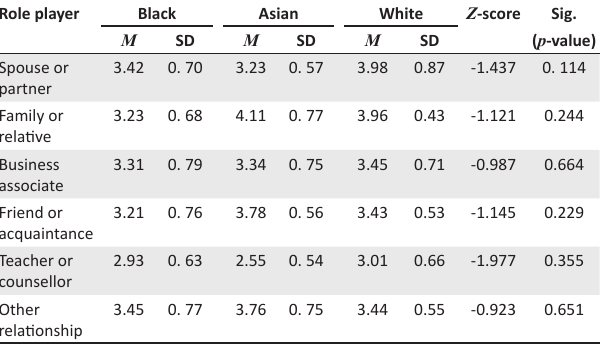
TABLE 3: Statistics for networking support relationship between ethnic